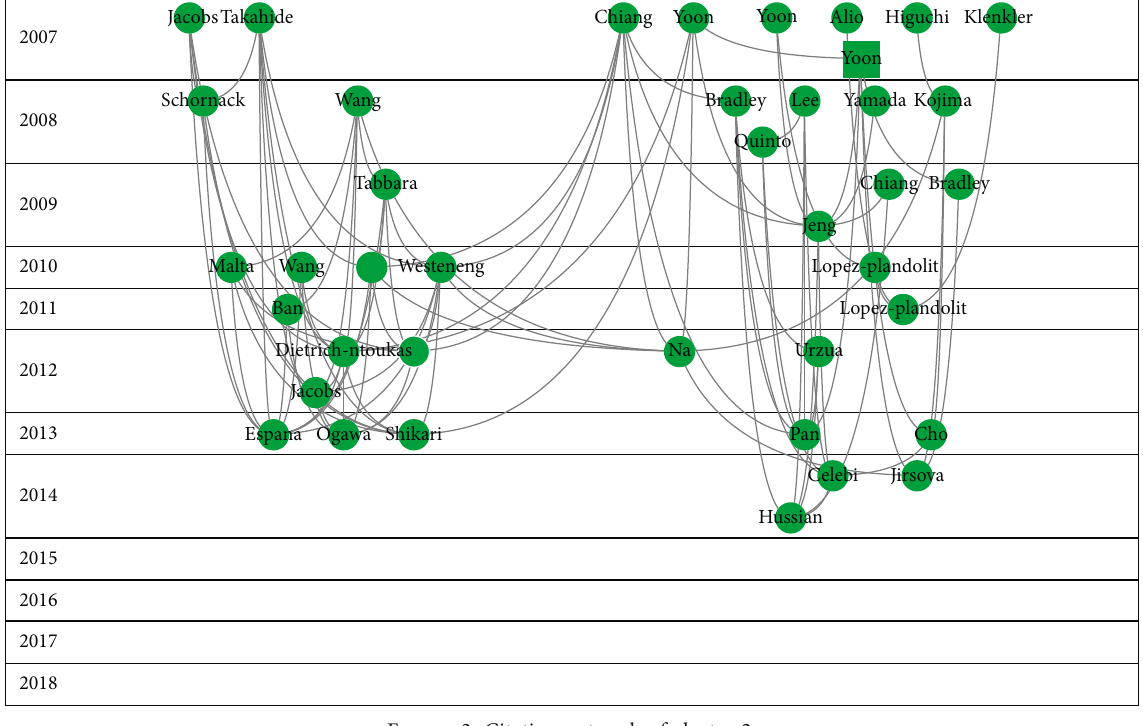
Figure 3: Citation network of cluster 2.